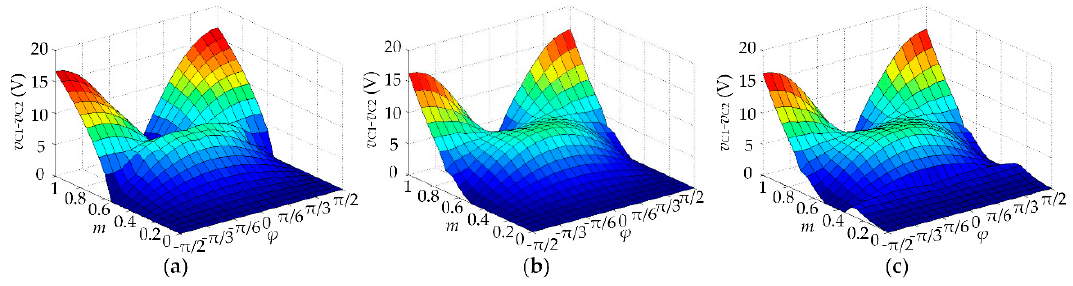
Figure 13. The dependence of neutral point voltage ripple v C1 - v C2 on m and ϕ : ( a ) CPWM; ( b ) DPWM3; ( c ) proposed strategy.